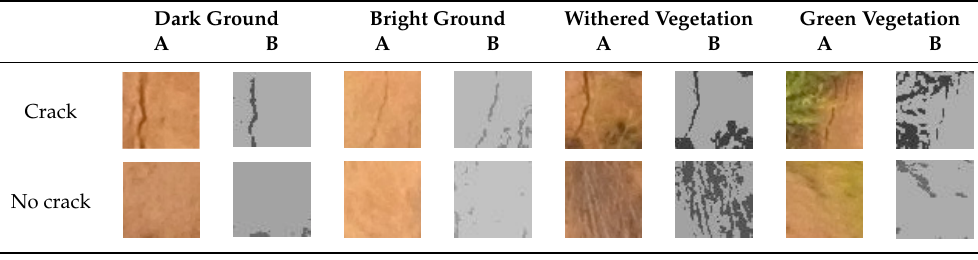
Table 8. Schematic diagram of the effect of the image after M2GLD and original image.